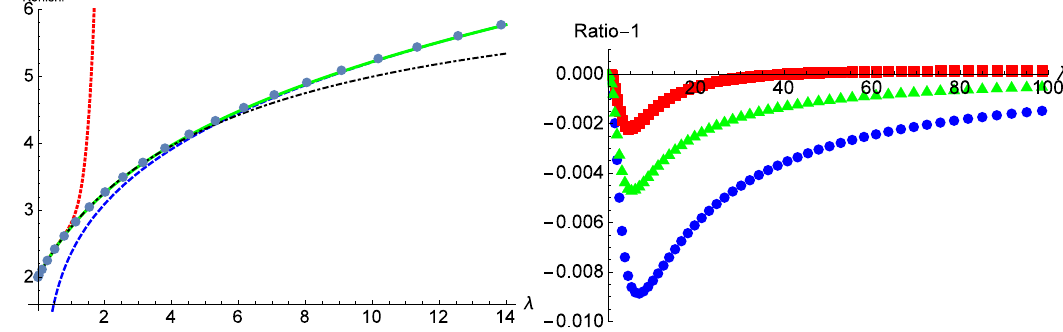
Figure 17 . [Left] Results on the dimension of Konishi operator in the planar limit. The symbol denotes the numerical result obtained by TBA the lines denote the weak coupling expansion (red dotted), strong coupling expansion (blue dashed), one point Pad(cid:19)e approximation P dot-dashed) and FPR with ( m; n; (cid:11) ) = (15 ; 2 ; 1 = 28) (green solid). [Right] The relative errors of the interpolating functions from the TBA result. Blue circle, red square and green triangle denote ( m; n; (cid:11) ) = (15 ; 2 ; 1 = 36), ( m; n; (cid:11) ) = (15 ; 2 ; 1 = 32) and ( m; n; (cid:11) ) = (15 ; 2 ; 1 = 28),